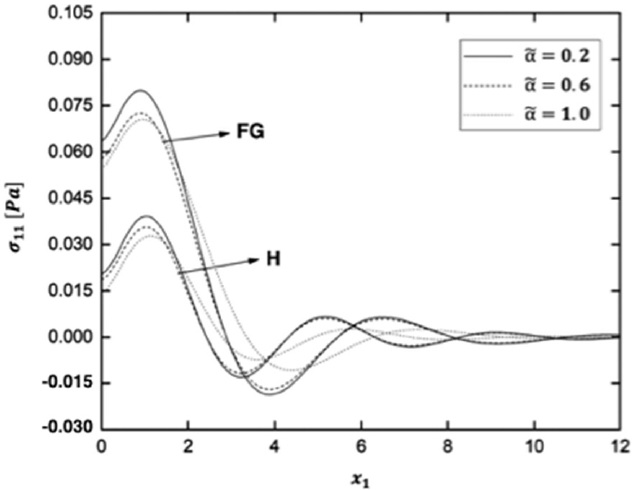
Figure 2. Variation of the thermal stress wave σ 11 along x 1 –axis in the functionally graded (FG) and homogeneous (H) anisotropic fiber-reinforced plates under different fractional order parameters.